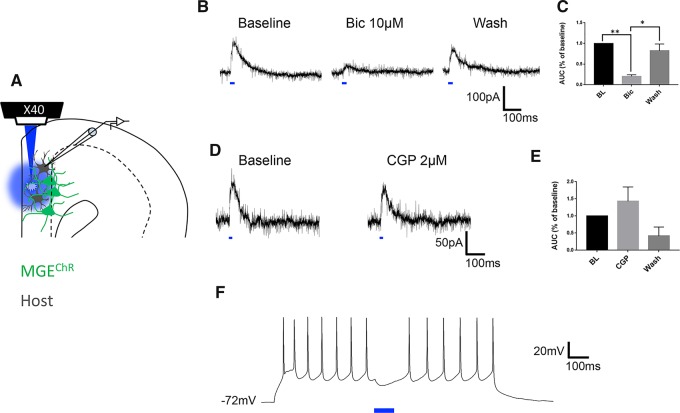

MGE-evoked inhibition is GABA-A receptor mediated. (A) Schematic illustrates the optogenetic approach to stimulate (blue light) populations of MGE cells (green) and study the pharmacology their inhibition of host pyramidal cells (black). (B) Optogenetic activation of MGE cells (blue bar) evokes bicuculline (Bic)-sensitive IPSCs in host pyramidal neurons: Baseline, after bicuculline and after a 10-min wash. (C) The magnitude of the evoked IPSCs (expressed as area under the curve) was significantly reduced by bicuculline and recovered to baseline (BL) after wash (n = 10; baseline versus bicuculline, **P < 0.01; *P < 0.05 Friedman test with Dunn’s multiple comparison correction). (D and E) The GABA-B receptor antagonist CGP55845 did not alter the magnitude of the optogenetically-evoked IPSCs. (F) Optogenetic stimulation of MGE cells (blue bar; 100 ms), transiently blocked evoked firing in the host pyramidal neuron.